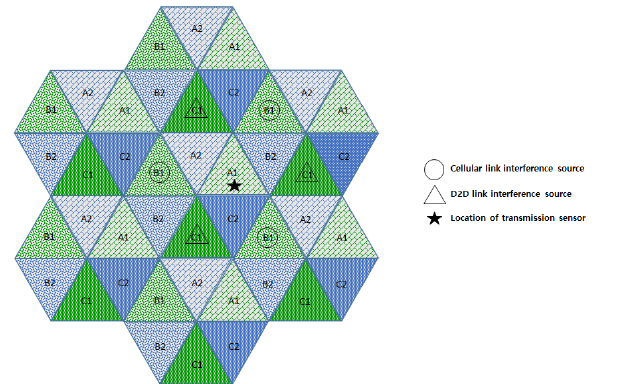
Figure 8. Interference sources to the target cellular link in FFR-3.